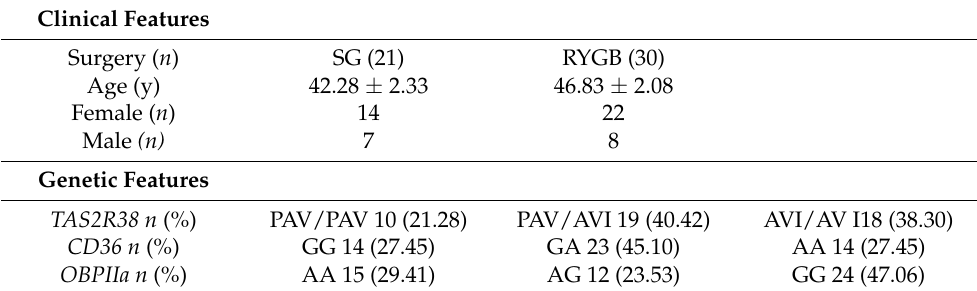
Table 1. Demographic, clinical and genetic features of